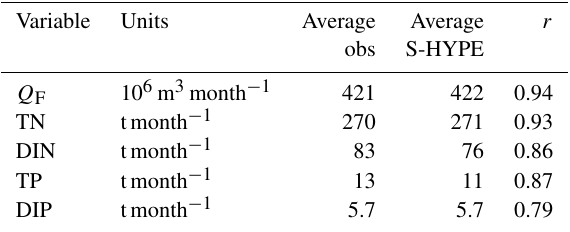
Table 2. The maximum concentrations of P and N (mgL − 1 ) in the discharge from sewage treatment plants of different size (person equivalents, pe).